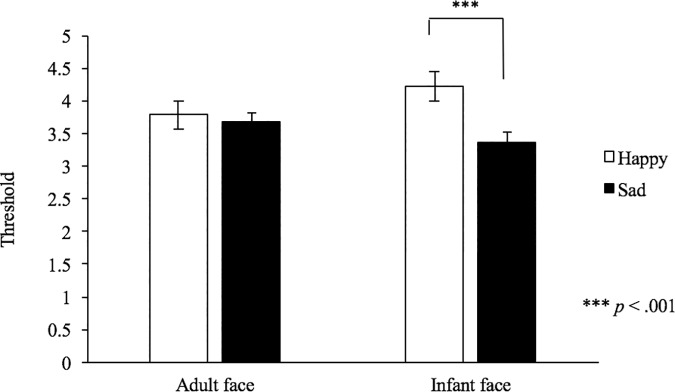
Difference in perceptual sensitivity for infant and adult facial expressions.The vertical axis indicates the detection thresholds.